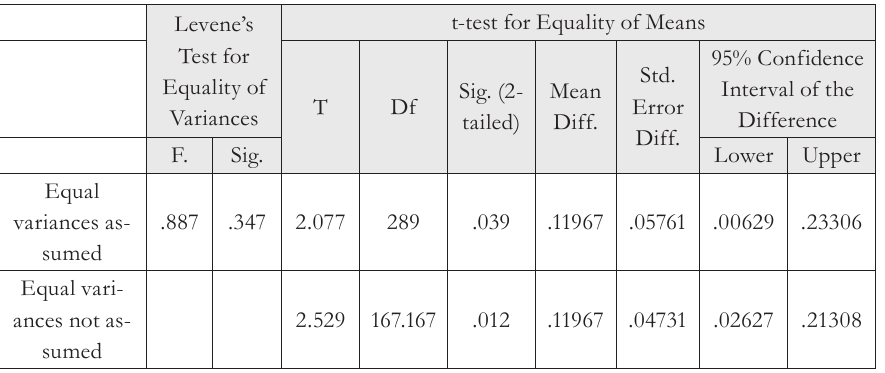
Tab. 7 – Difference in productivity between 2008 and 2011 for firms with support of the ESF – test statistics. Source: Survey, CZSO, own